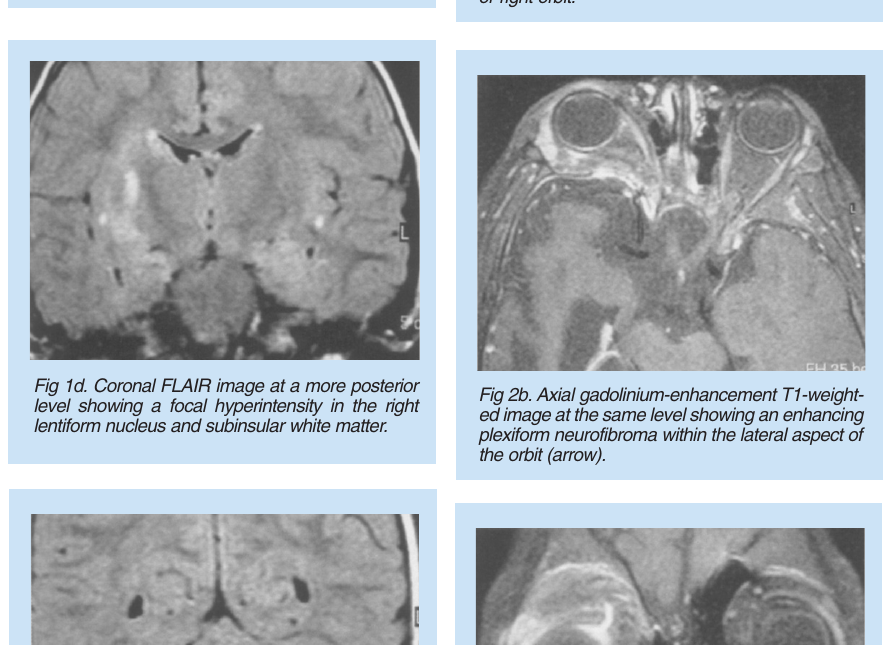
Fig 2a. Axial T2-weighted image shows dysplasia of the right sphenoid wing with herniation of the peritemporal subarachnoid space into the posteri- or right orbit.